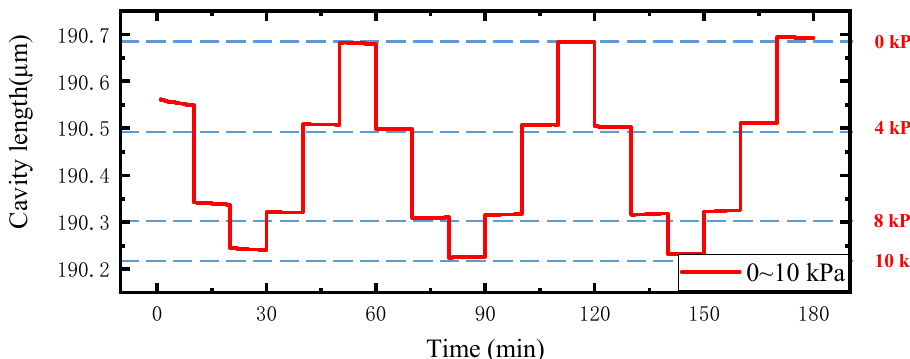
Figure 16. Stability test results.